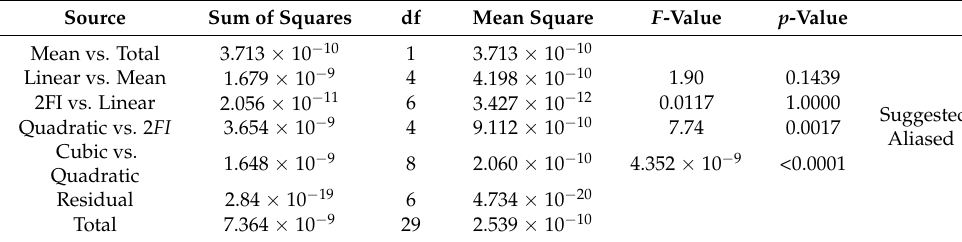
Table 6. Model summary statistics for response strain ( ε